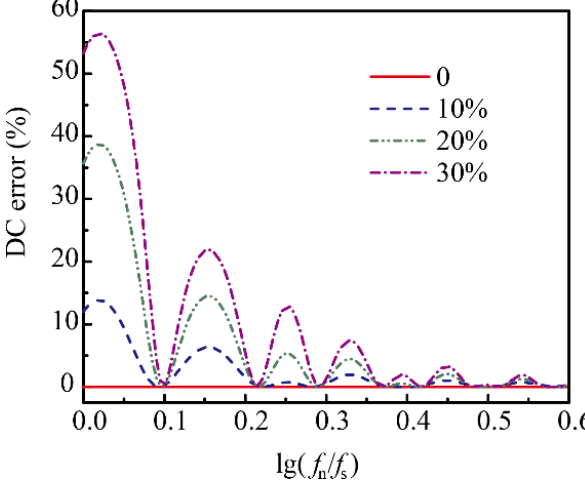
Figure 11. Inversion errors of DC proportions for the spectrum differences between signals and noise. f n is the frequency of sinusoidal noise and f s is the dominant frequency of signals. Line types represent the results of four noise levels.